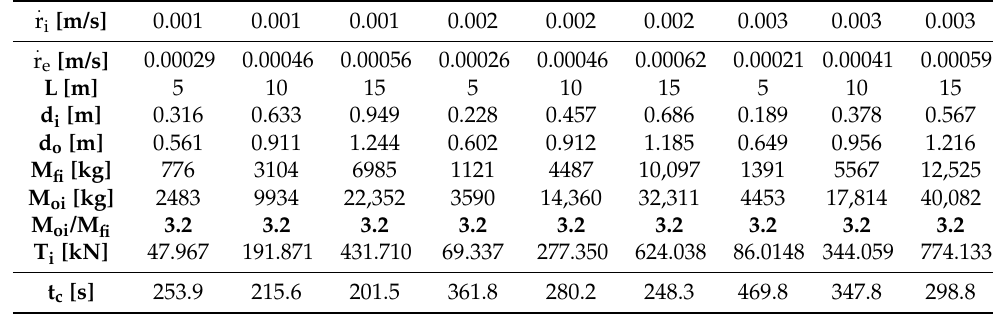
Table 6. Numerical results for R TM,i = 1.5 and imposed L,